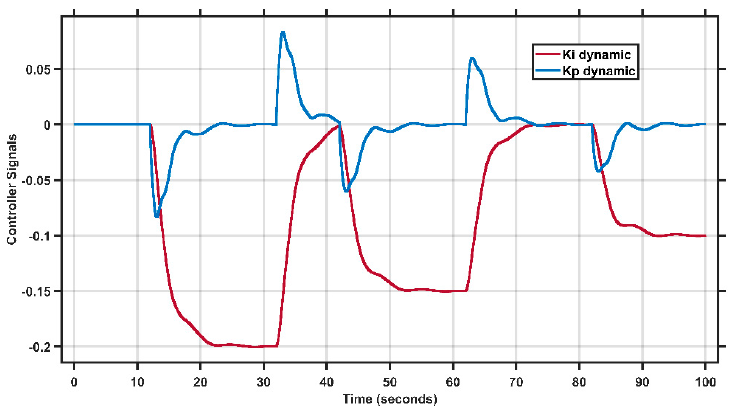
Figure 13. The output control signals of the fuzzy PI controller in case 2.